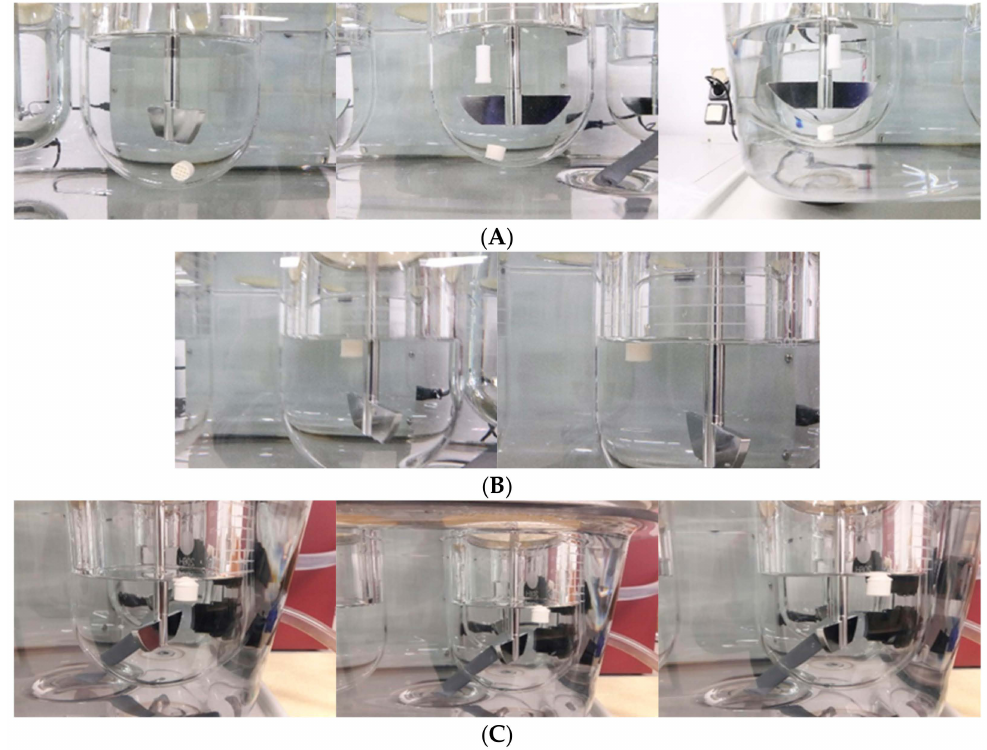
Figure 5. Floating study of prepared formulations. Open system ( A ), closed system ( B ), and optimized formulation ( C ) over 1, 8 and 24 h (left to right).